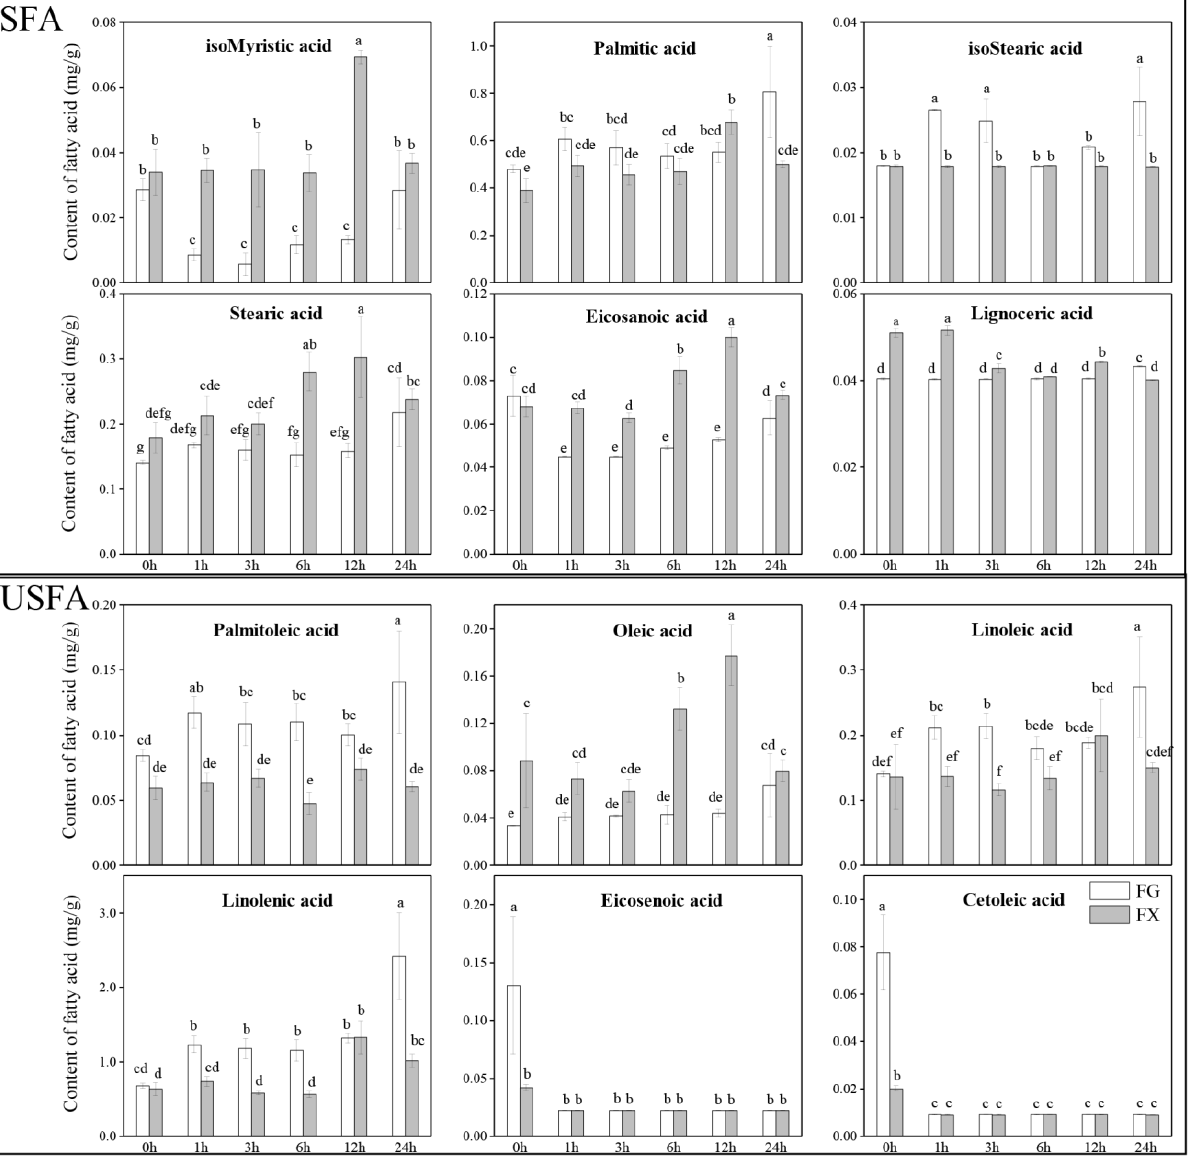
Figure 1. Fatty acid profiling of FG and FX leaf samples under 4 °C low-temperature stress for 24 h. ( SFA ): saturated fatty acid; ( USFA ): unsaturated fatty acid. The data bars represent the mean value of 3 samples taken at each time point, and the error bars represent the standard deviation. The letters above the data bars mean significance at p < 0.05. Table 1. Indexes of fatty acid composition in FG and FX leaf samples under 4 °C low-temperature stress for 24 h.